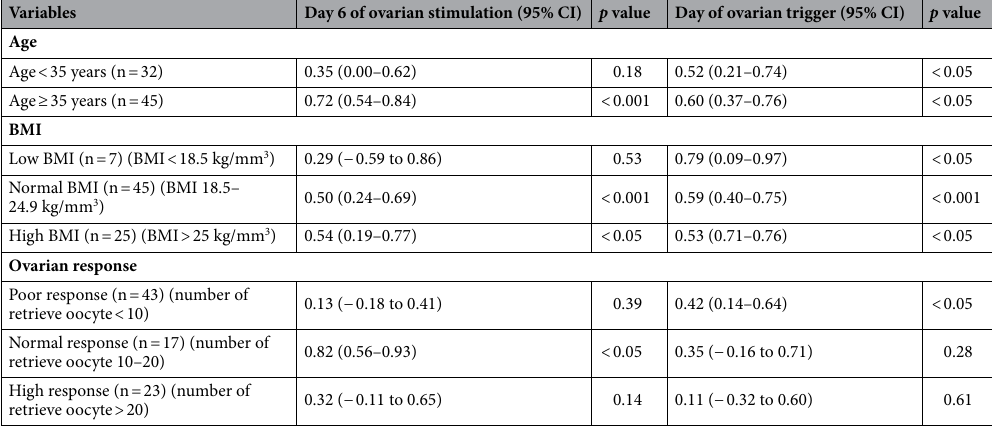
Table 4. Spearman correlations of urine and serum estradiol in subgroup